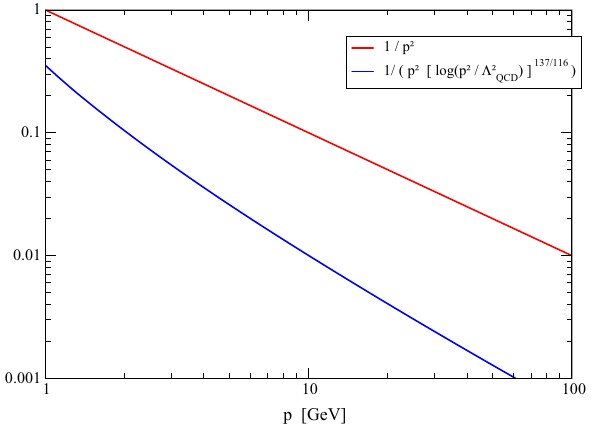
Fig. 3 Large p behaviour and logarithmic corrections. The plotted function uses Λ QCD = 0 . 3